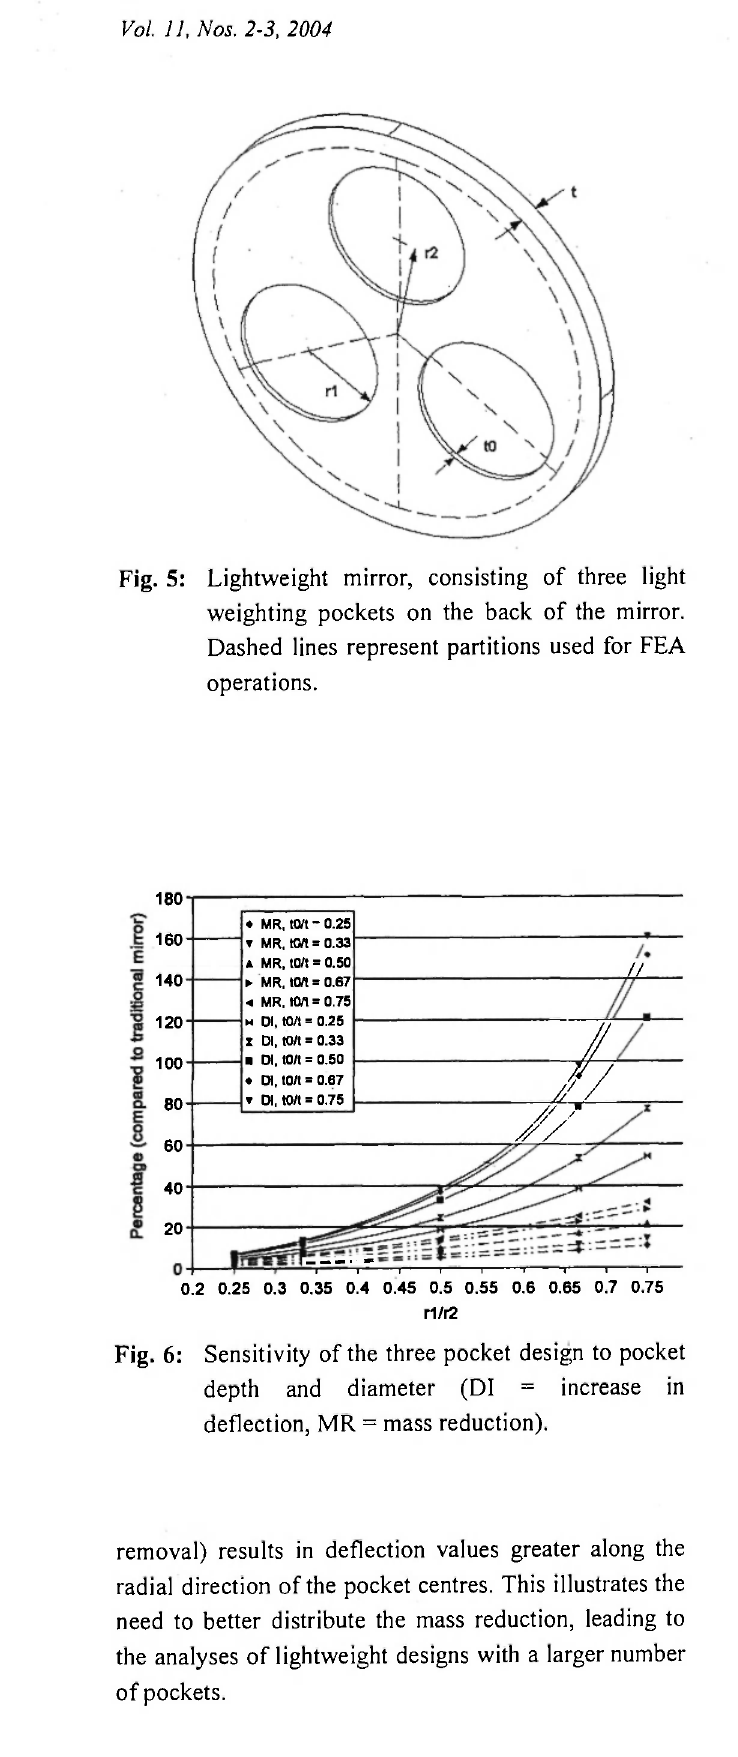
Fig. 6: Sensitivity of the three pocket design to pocket depth and diameter (DI = increase in deflection, MR = mass